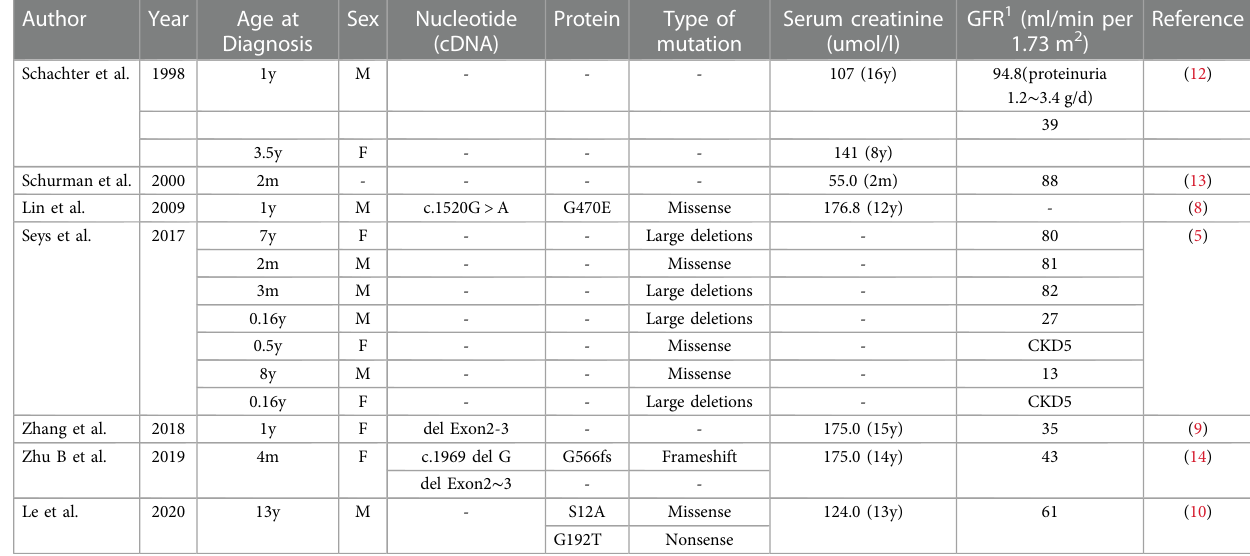
TABLE 2 Genotype and clinical features of each cBS and